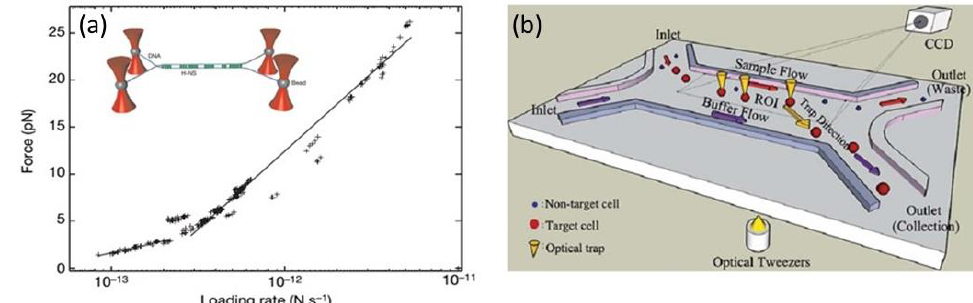
Figure 1. ( a ) Inset: Scheme of λ-DNA molecules linked by H-NS suspended between polystyrene beads held with optical tweezers; Dynamic force spectrum of the H-NS–DNA interaction. The two distinct regions in the Spectrum are fitted to straight lines. (Reprinted with permission from Springer Nature [50]); and, ( b ) Scheme of a lab-on-a-chip sorting procedure with optical tweezers (Reproduced from [51] with permission of the Royal Society of Chemistry).